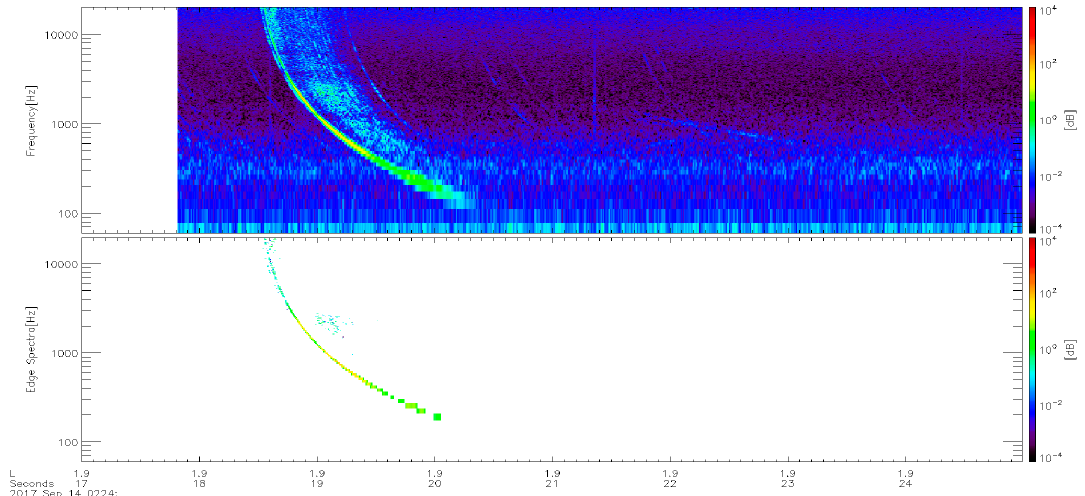
Figure 4. ( top ) The original middle whistler dynamic spectra observed at 02:24:17 UT on September 14, 2017. ( bottom ) Edge spectra after using a Gaussian blur with a mask (1,0.1) and Laplacian filtering to remove noise. Table 2. Total numbers of the spectra image file as a function of month.